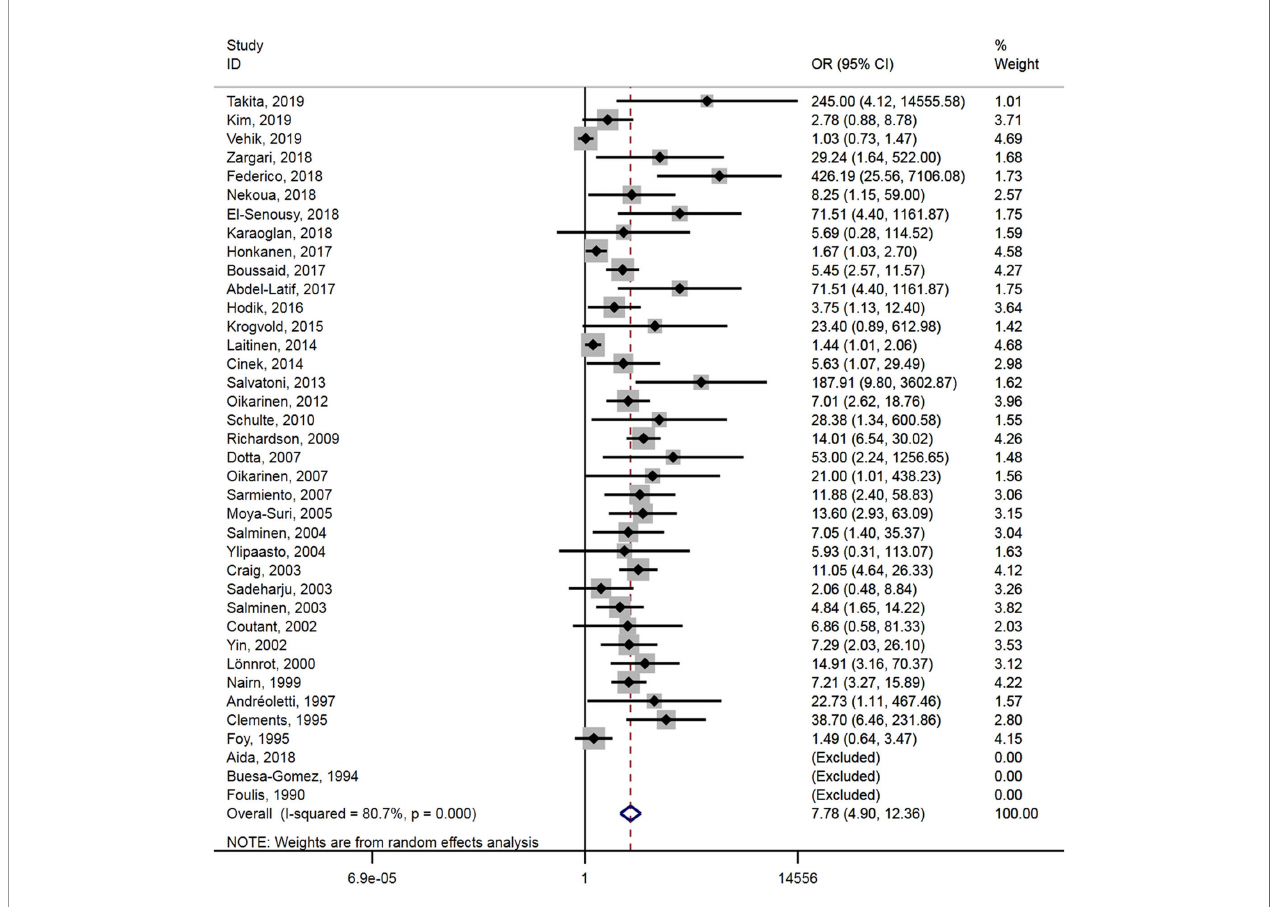
FIGURE 2 | Forest plot of ORs of enterovirus and type 1